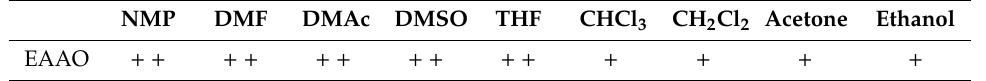
Table 1. Solubility of EAAO in common organic solvents a .